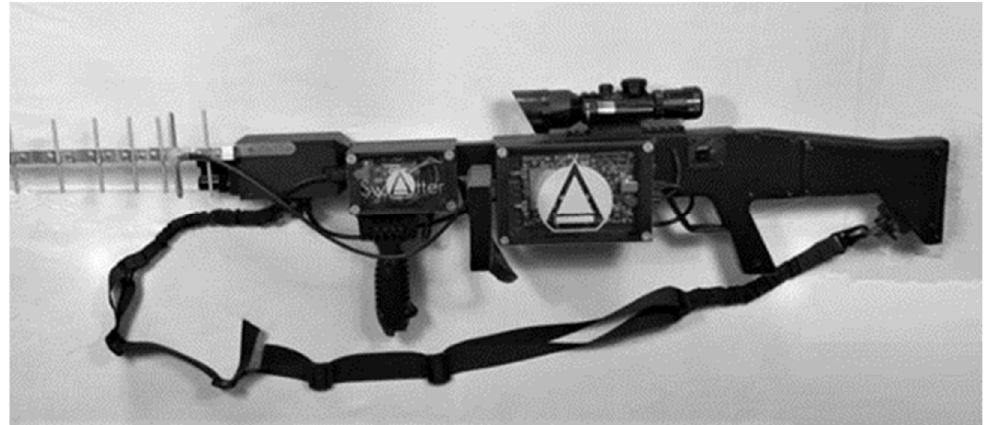
Figure 6. System Anti-UAVs.